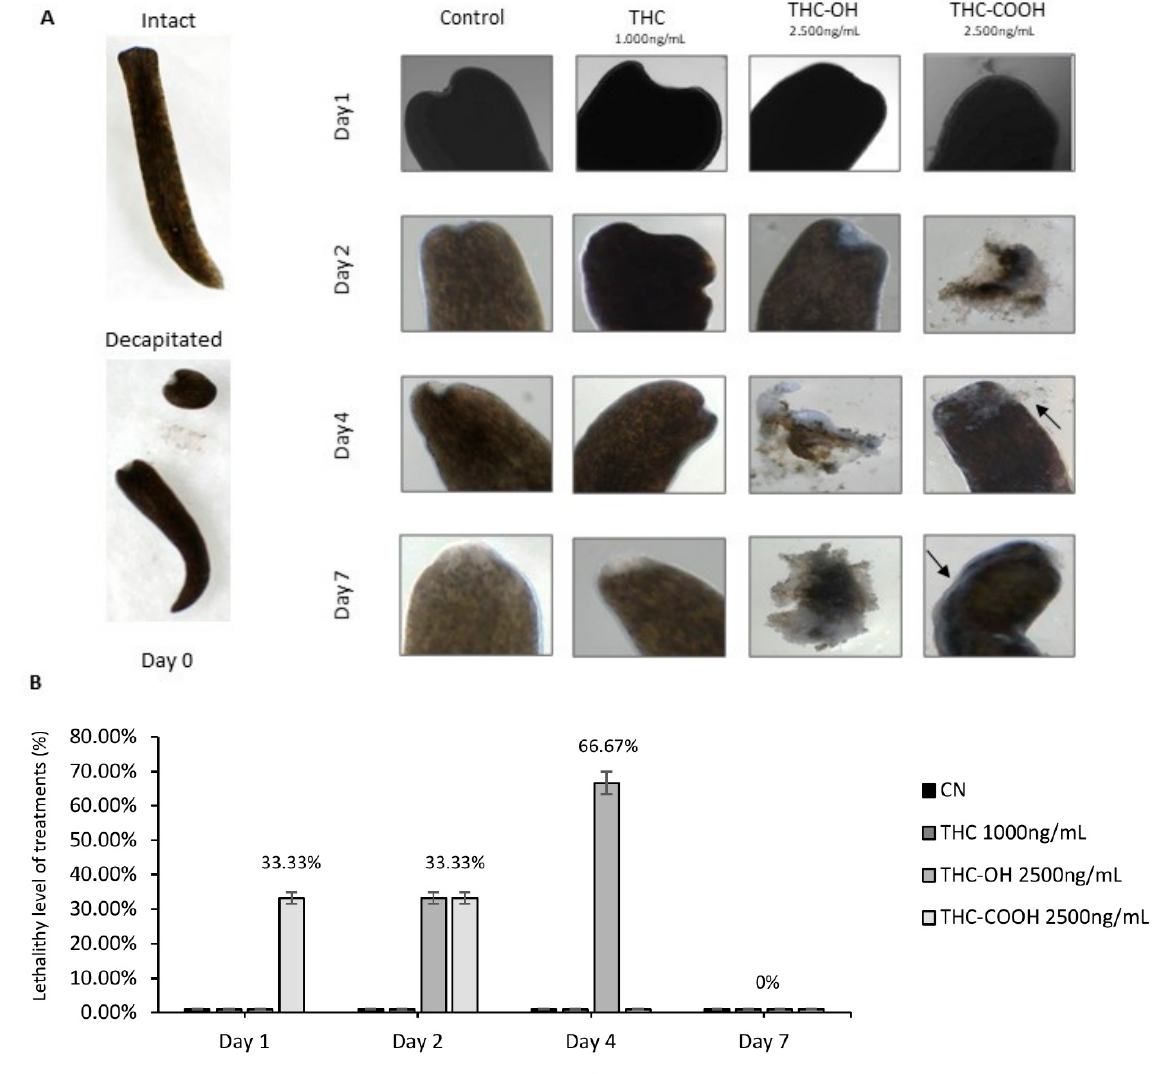
Figure 7 . High dose cannabinoids treatments induce toxicity in Polycelis nigra . ( A ) High dose drug concentration treatment of THC (1000 ng/mL), and its metabolites (both 2500 ng/mL) in decapitated planaria observed for a week for regeneration and toxicity. ( B ) THC-OH and THC-COOH demon- strated toxicity in high dose, while THC-OH caused rapid disintegration and THC-COOH showed slower disintegration in which structural integrity was protected for a longer period of time. The arrows highlight the slower disintergration seen in THC-COOH treatments versus that of